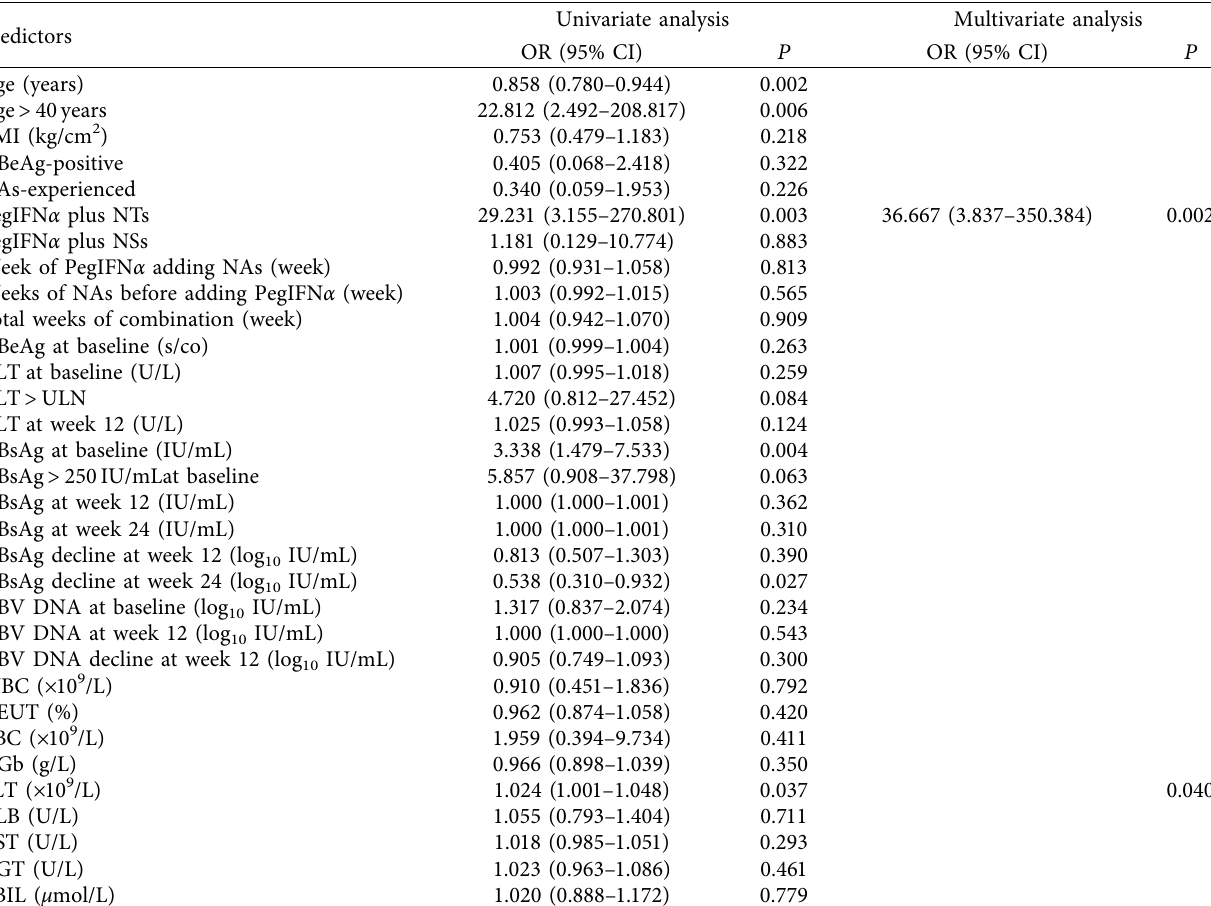
Table 4: Multivariate logistic regression of HBsAg reduction > 1 log